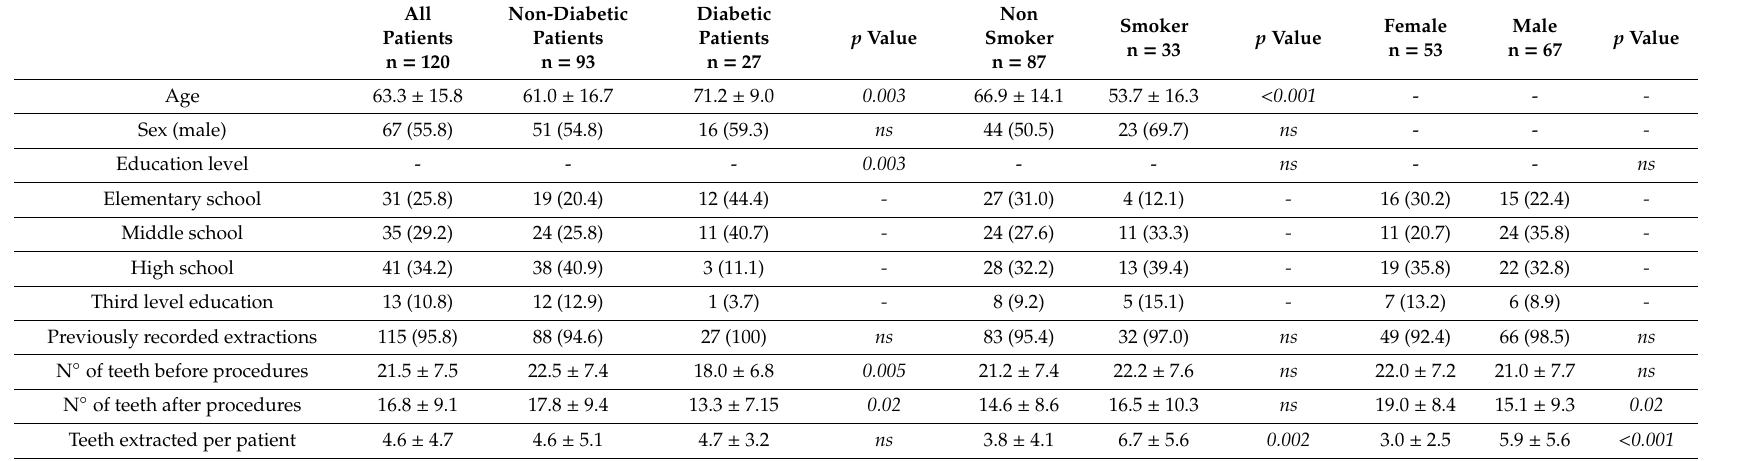
Table 2. Clinical variables stratified by smoking habits, gender and